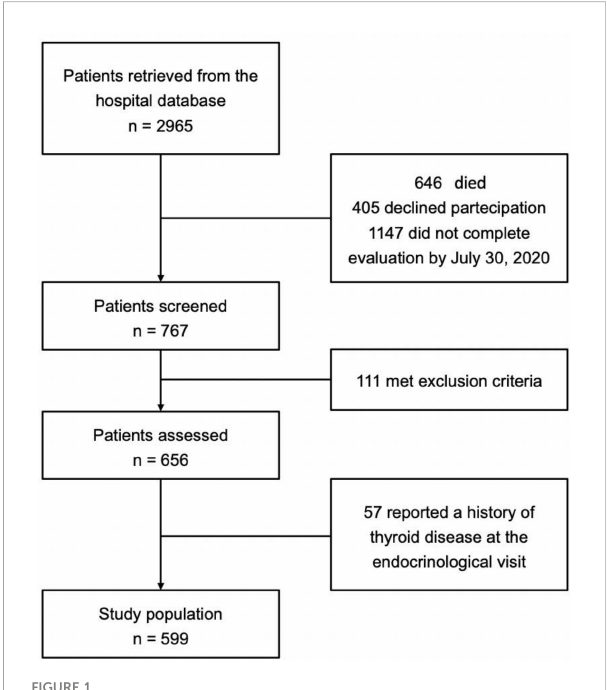
FIGURE 1 Flow chart of screened, included, and excluded